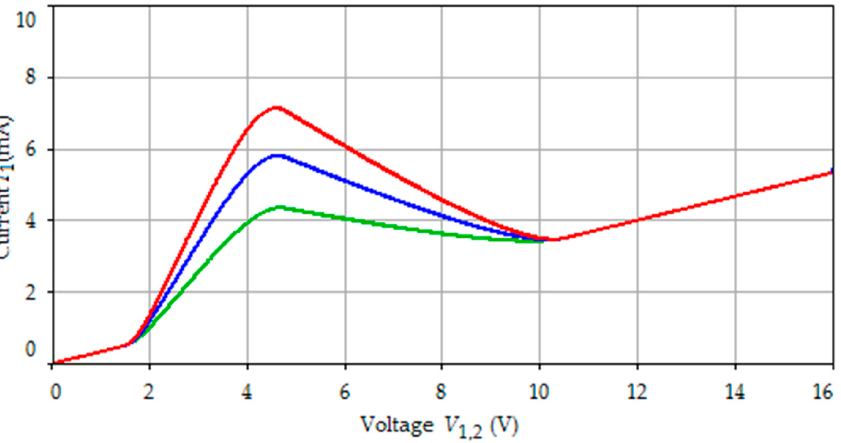
Figure 12. Current-voltage characteristics of the two-terminal NDR circuit with multiple-output cascode current mirror; m = 0—green curve, m = 1—blue curve, m = 2—red curve.